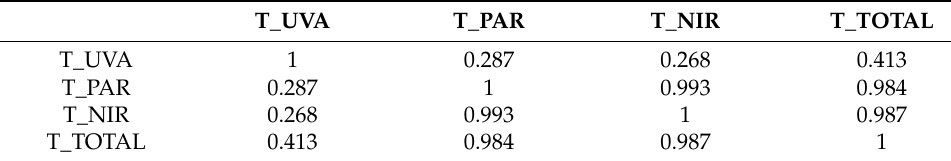
Table 4. Correlations between transmitted radiation in different regions.